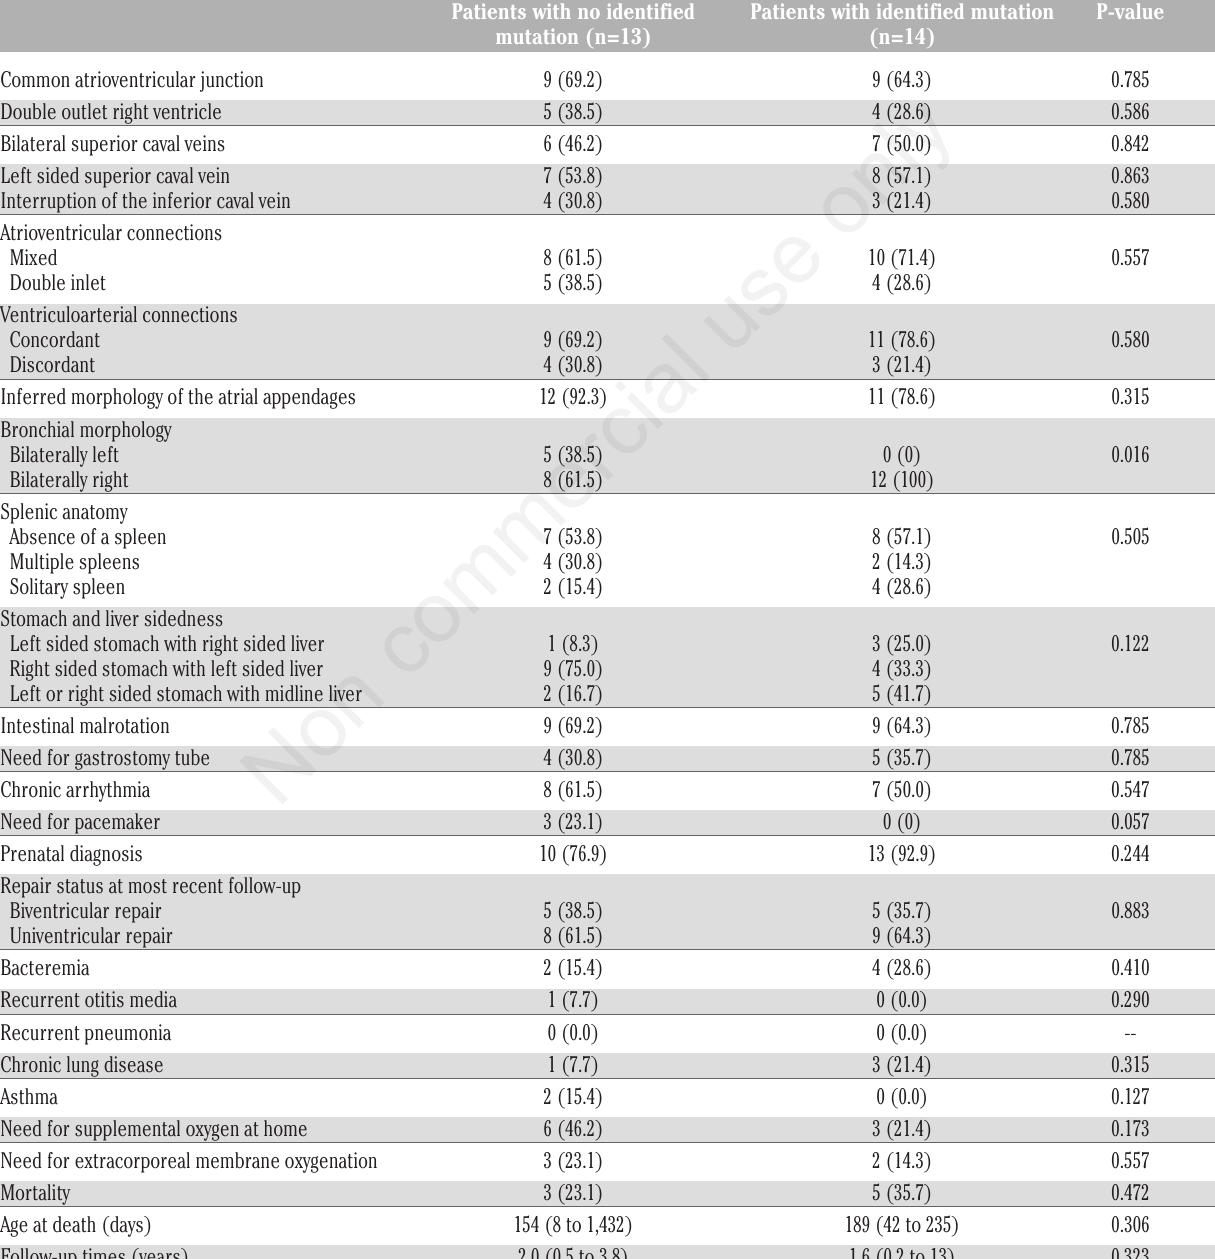
Table 1. Patient characteristics based on isomerism